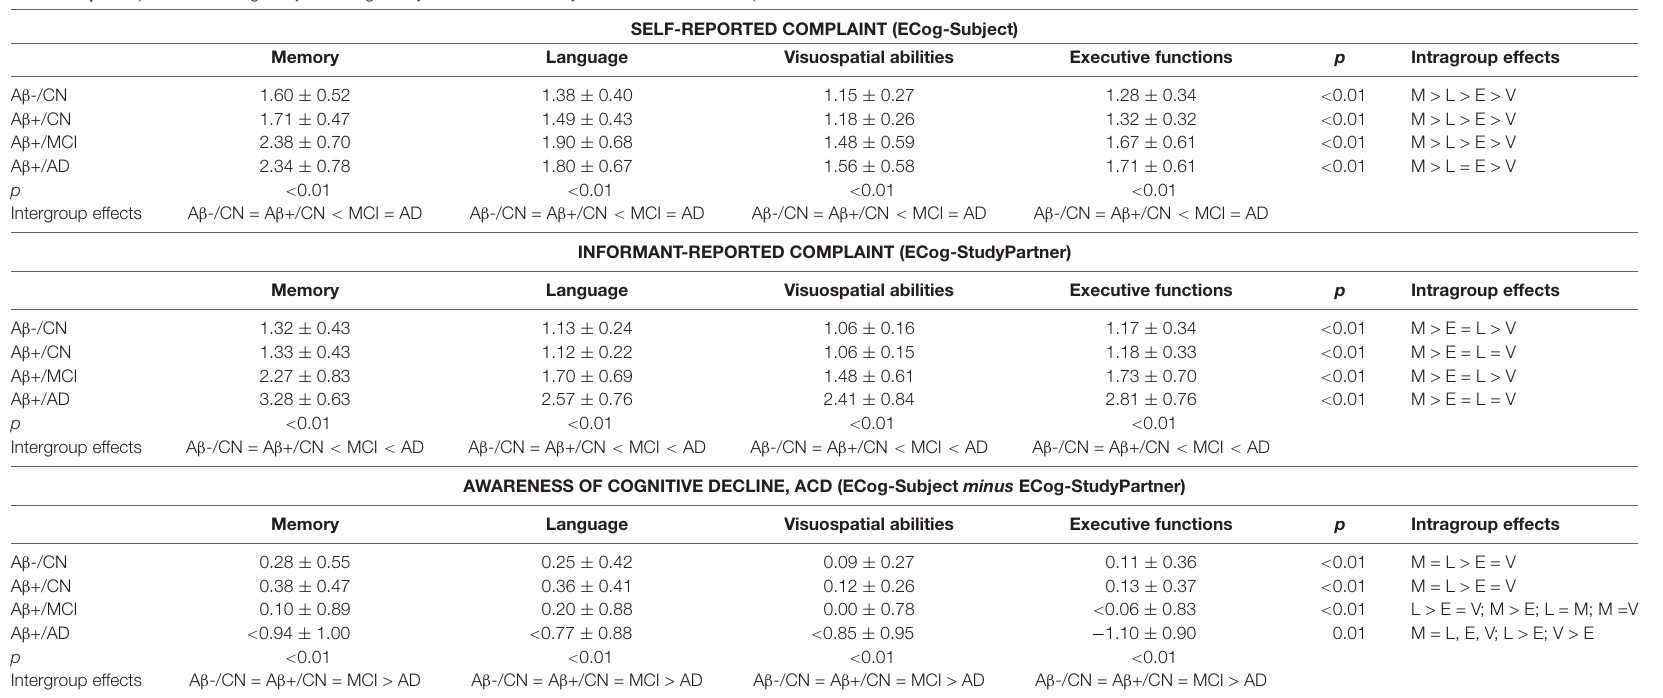
TABLE 2 | Comparison of ECog-Subject, ECog-StudyPartner, and ACD by Domain between